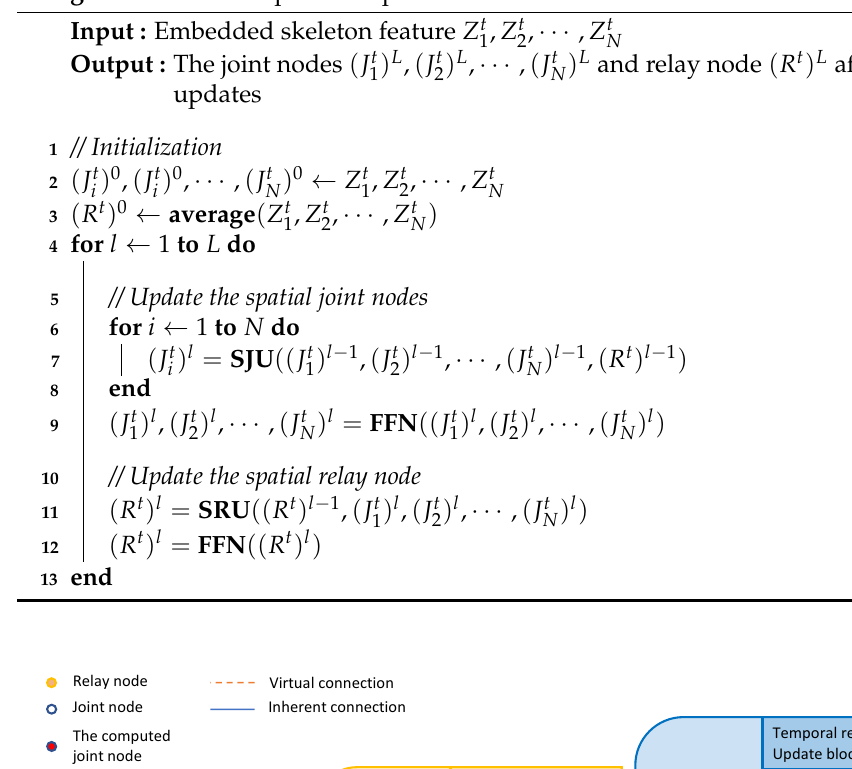
Algorithme 1 : The update of spatial relative transformer